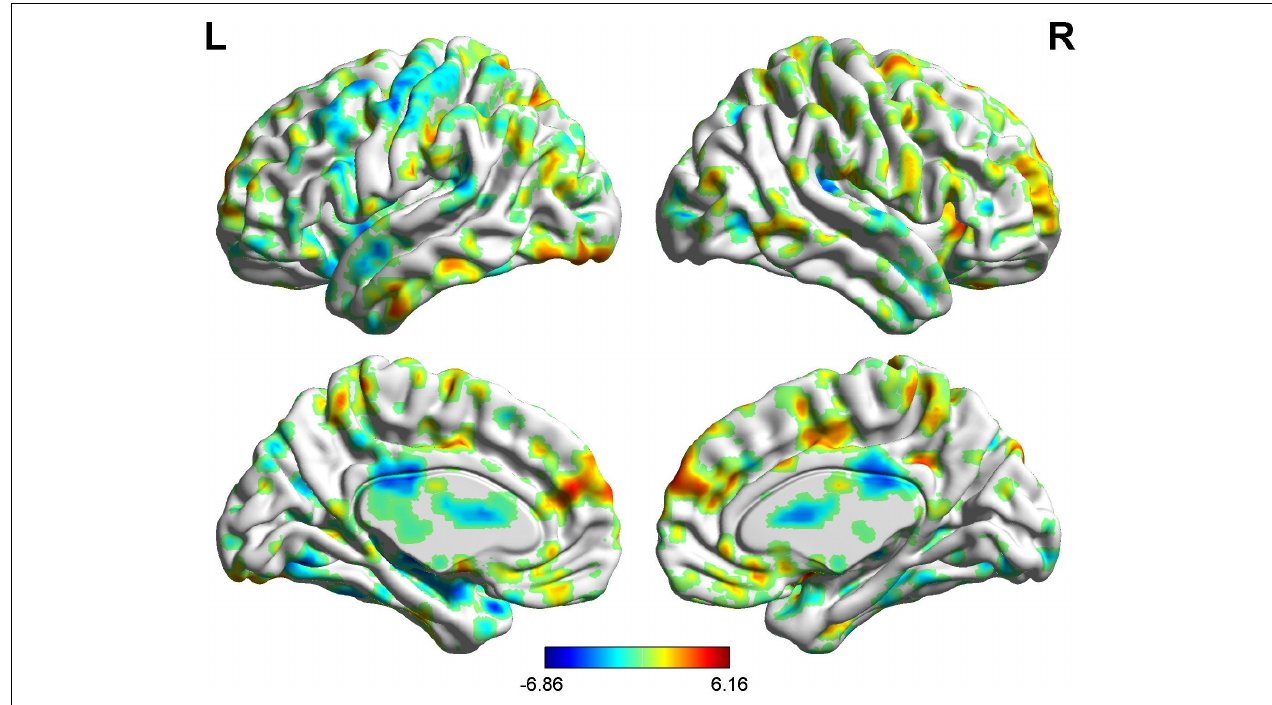
FIGURE 11 | Brain areas showing functional connectivity with the rACC in comparison of male participants and female participants in nocebo response. Color scale represents the Z -score. Red = male > female; blue = female > male.